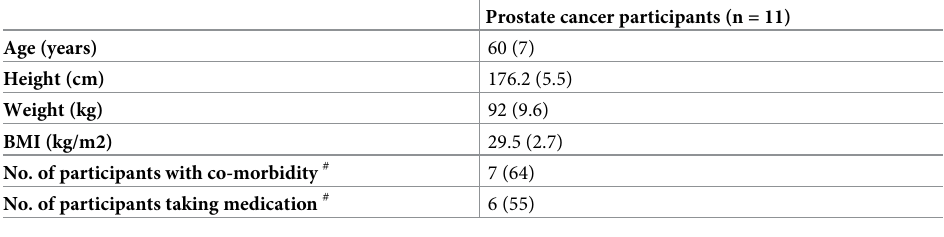
Table 2. Participant